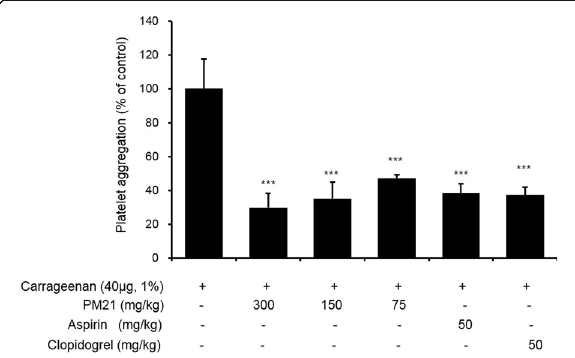
Fig. 8 Ex vivo effects of PM21 on platelet aggregation. PM21 (75 mg/kg, 150 mg/kg, and 300 mg/kg) was orally administered 1 h before carrageenan injection, and thereafter three more treatments with 24 h interval for 3 days. Aspirin or clopidogrel was administered to positive control groups at the dose of 50 mg/kg. Blood was collected 1 h after the final treatment. Platelet aggregation was induced by adding 5 μ g/mL collagen and terminated after 5 min, and monitored by measuring light transmission with an aggregometer. Data show the mean±SEM of six measurements. *** p <0.001 versus vehicle